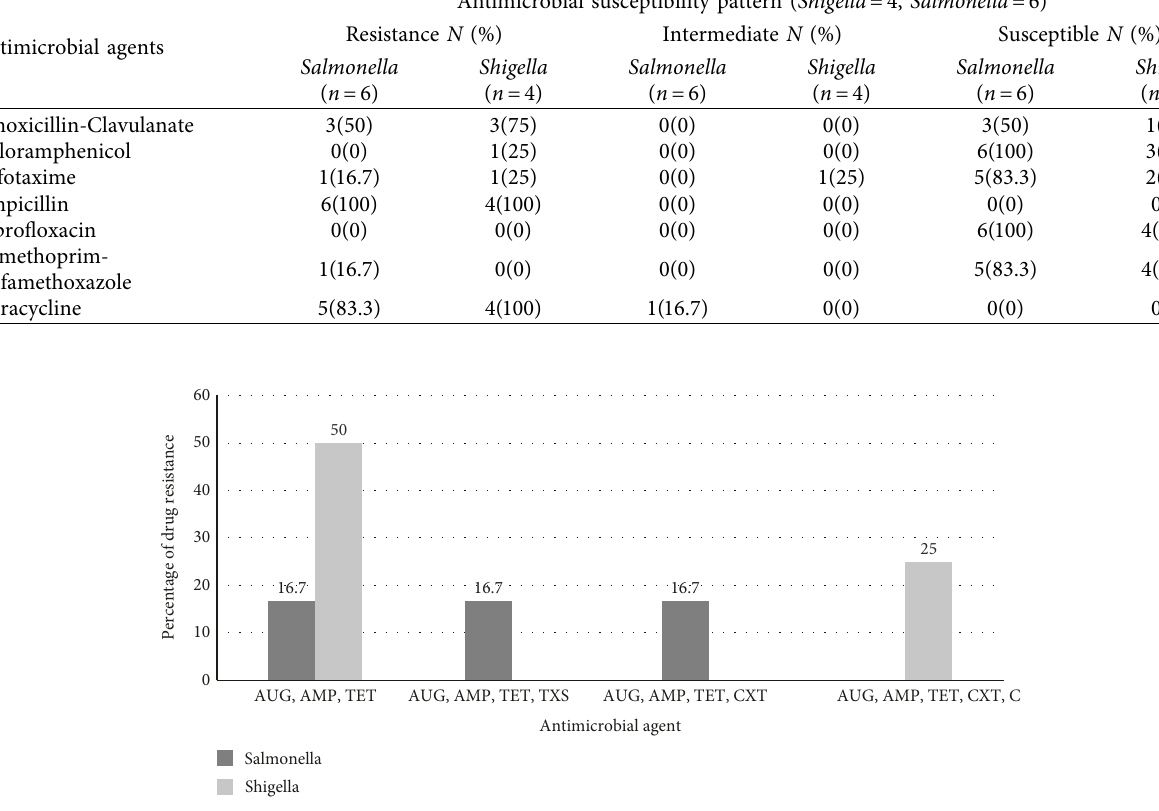
Figure 1: Multidrug resistance pattern of Salmonella and Shigella among food handlers in Motta town. AUG, amoxicillin-clavulanate, TET, tetracycline, AMP, ampicillin, TXS, trimethoprime-sulfamethoxazole, CXT, cefotaxime, and C,